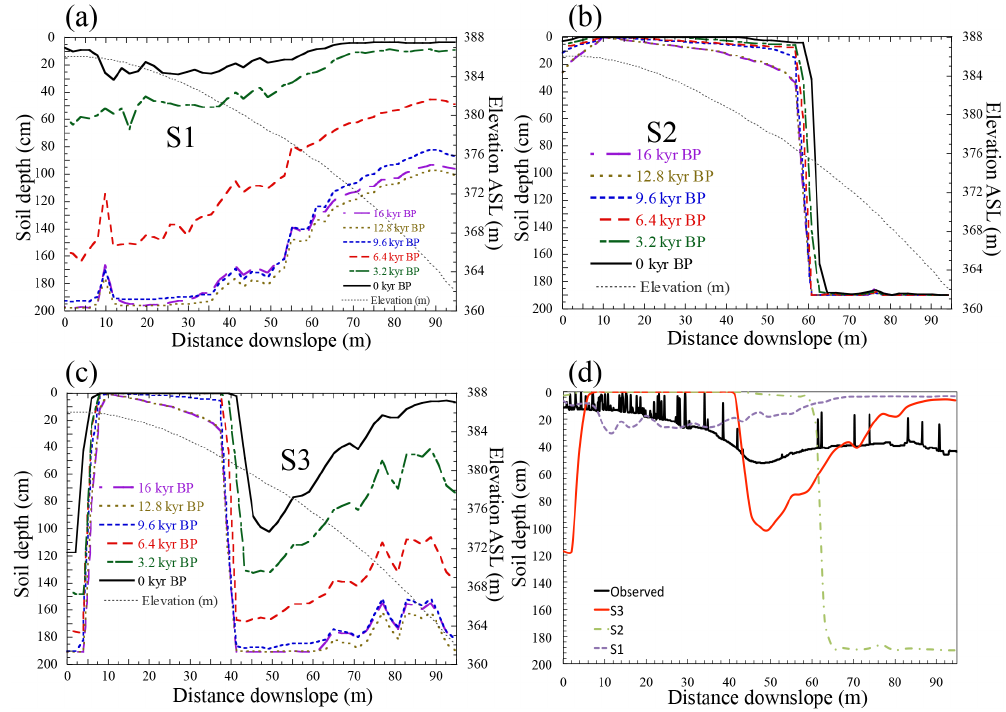
Figure 7. Soil depth across a transect (Fig. 1c) on the northeast-facing hillslope at six time intervals (corresponding to soil maps in Figs. 4– 6): (a) the fluvial-only simulation (S1), (b) the diffusive-only simulation (S2), (c) the combined simulation (S3), and (d) measured soil depth (Fig.